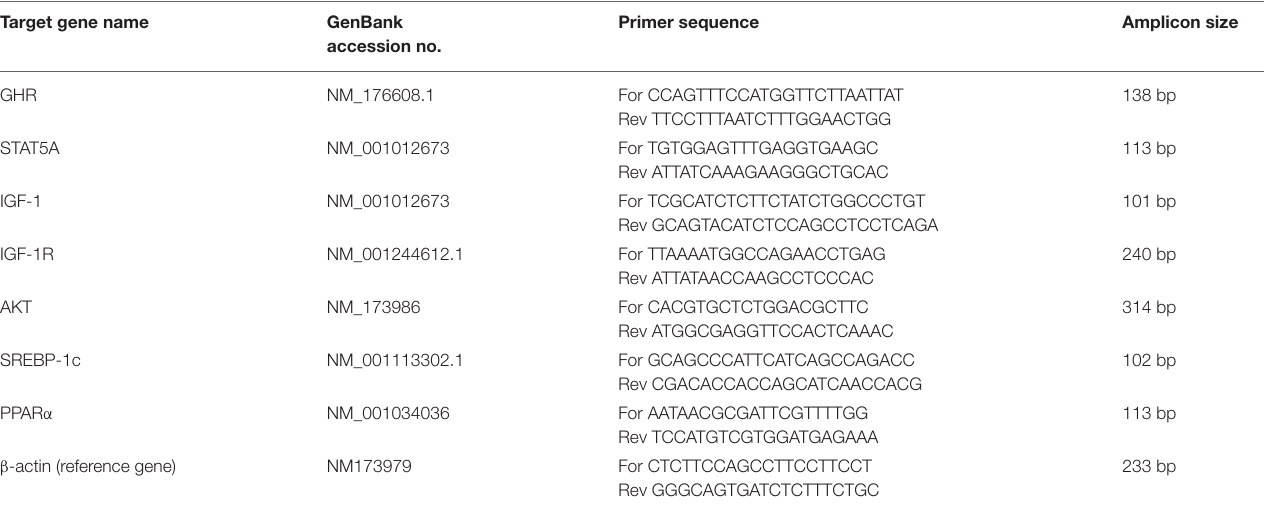
TABLE 2 | Sequence of target gene primers utilized in qRT-PCR